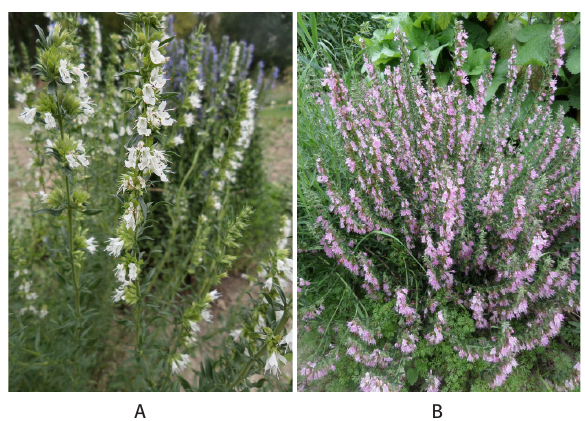
Photo 1: Hyssopus officinalis L. with white (A) and pink (B) flowers (Medicinal Plant Unit of Medical University, Lublin,